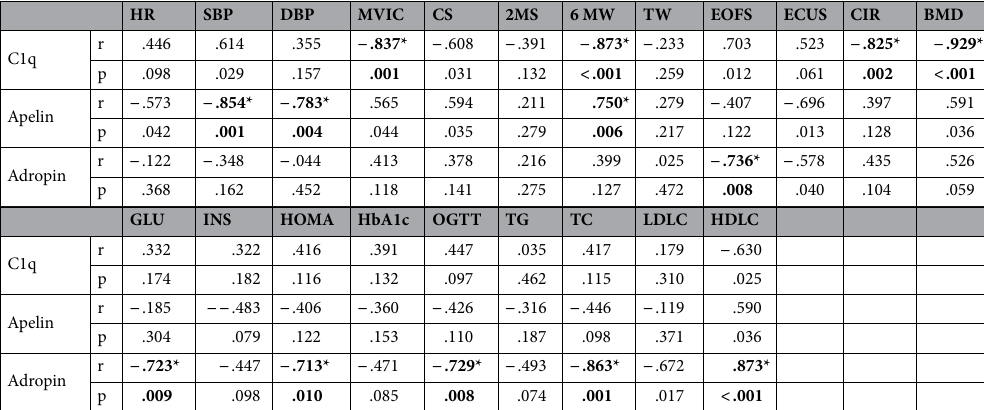
Table 3. Multiple partial correlations (partial r and p values) between the normalised changes in plasma complement component 1q (C1q), apelin and adropin concentrations between before and after 12 weeks of descending stair walking (DSW) training and the normalised changes in resting heart rate (HR), systolic (SBP) and diastolic blood pressure (DBP), the maximal voluntary isometric contraction strength of the knee extensors (MVIC), 30-s chair-stand (CS), 2-min step (2MS), 6-m walk (6 MW), 6-m tendon walk (TW) test performance, balance with eyes open on firm surface (EOFS) and eyes closed on unstable surface (ECUS), upper thigh circumference (CIR), and bone mineral density (BMD) [upper table], and resting glucose (GLU) and insulin (INS) levels, the homeostasis model assessment (HOMA) index, whole blood